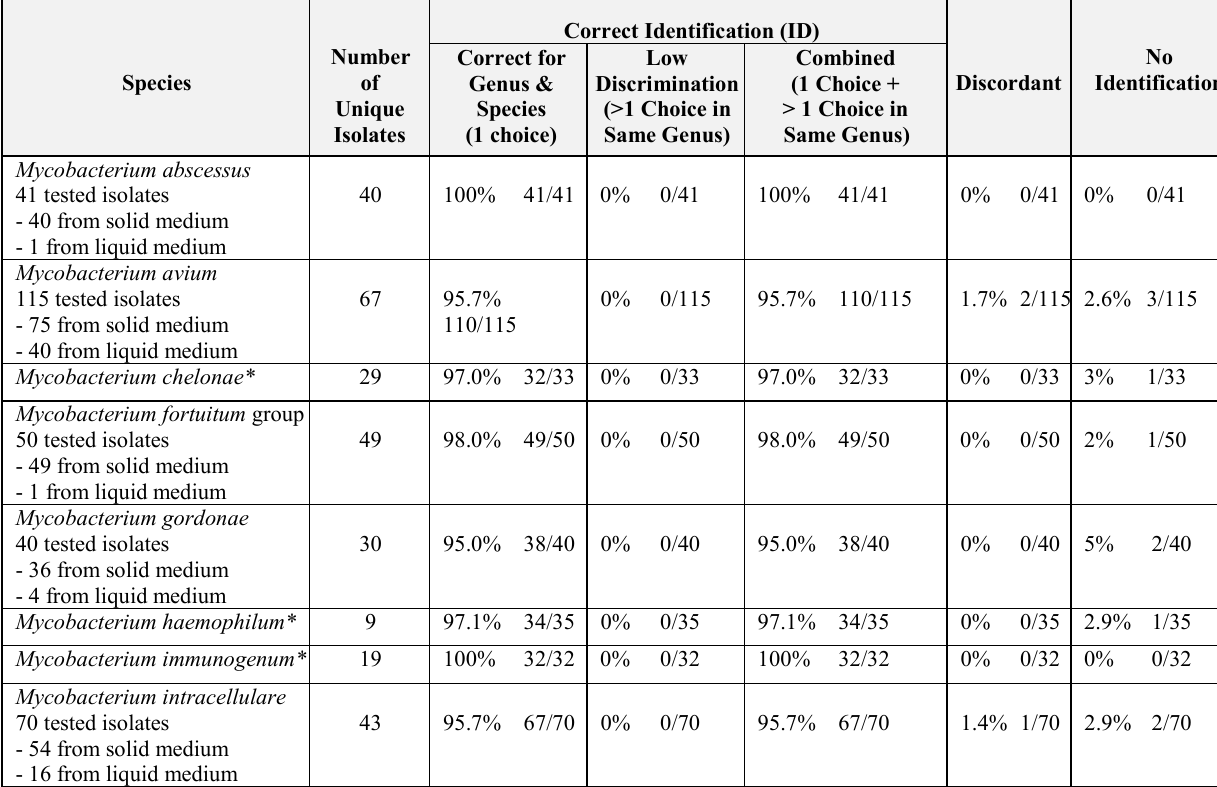
TABLE 14: Mycobacterium Performance with VITEK MS V3.0 Knowledge Base